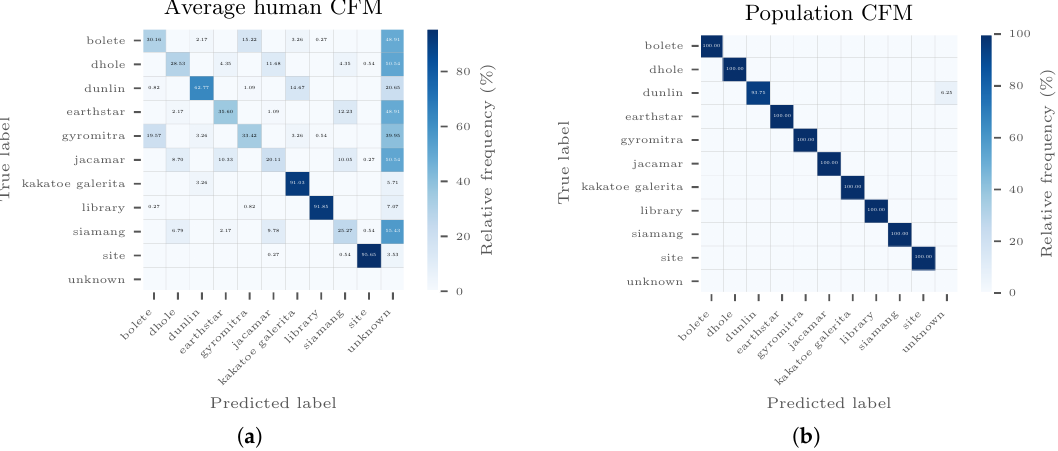
Figure A1. Obtained confusion matrices (CFM) for human subjects from the ILSVRC2012 experiment. The matrix in ( a ) represents averaged results for all human subjects. ( b ) shows a population